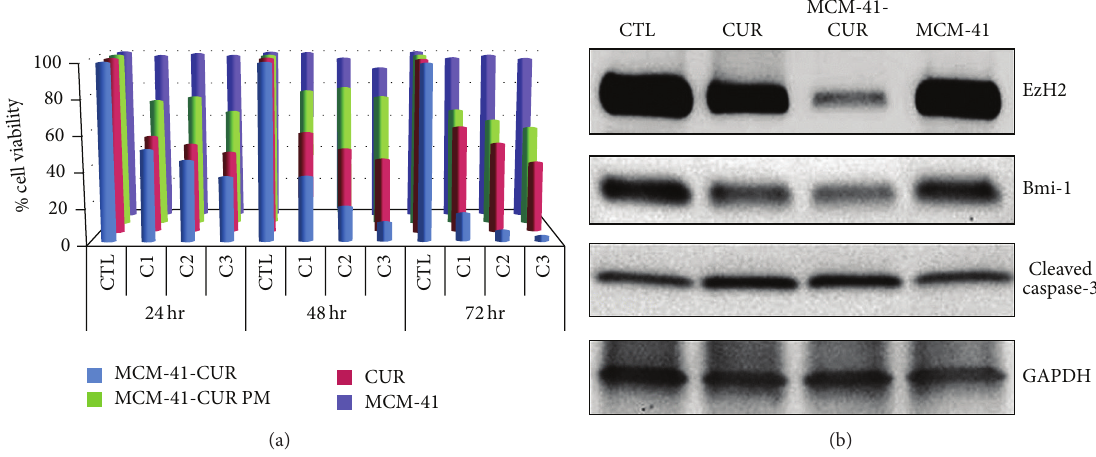
Figure 5: In vitro cytotoxicity of pure curcumin, MCM-41-CUR and MCM-41-CUR PM in SCC-25 cell line after 24, 48, and 72 h (a). CTL, C1, C2, and C3 denote the control group, curcumin equivalent dose of 15ppm, 30 ppm, and 45ppm, respectively, used in the cell cytotoxicity experiment. Protein expression studies using Western blot analysis for pure curcumin, MCM-41-CUR and MCM-41 (b)